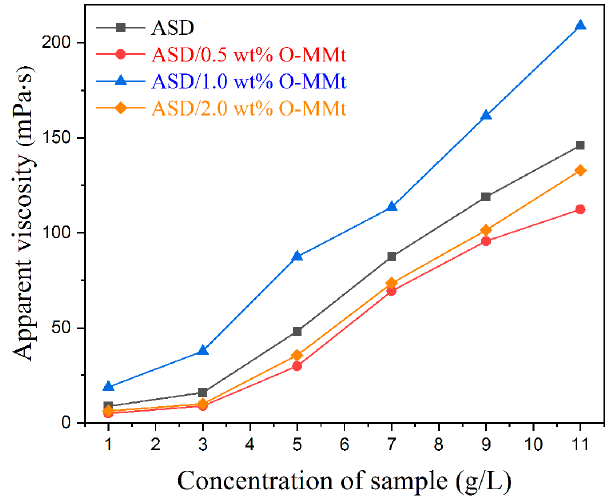
Figure 11. Apparent viscosity of the water-soluble polymer nanocomposites.